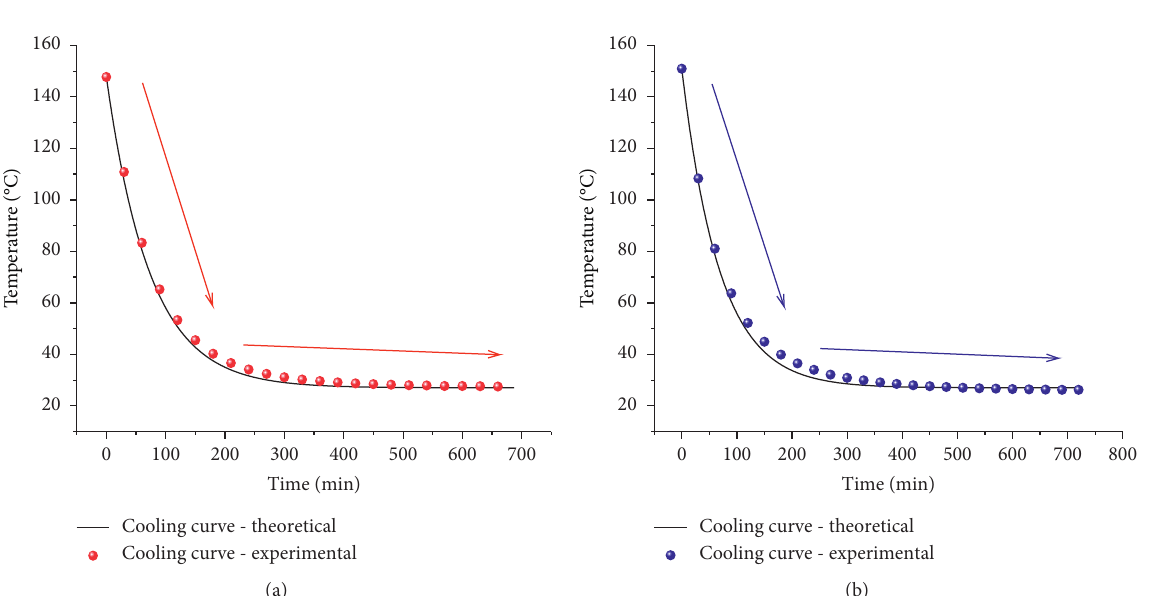
Figure 18: Comparison of the experimental and theoretical cooling curves. (a) Results of the cabin covered with C cabin.